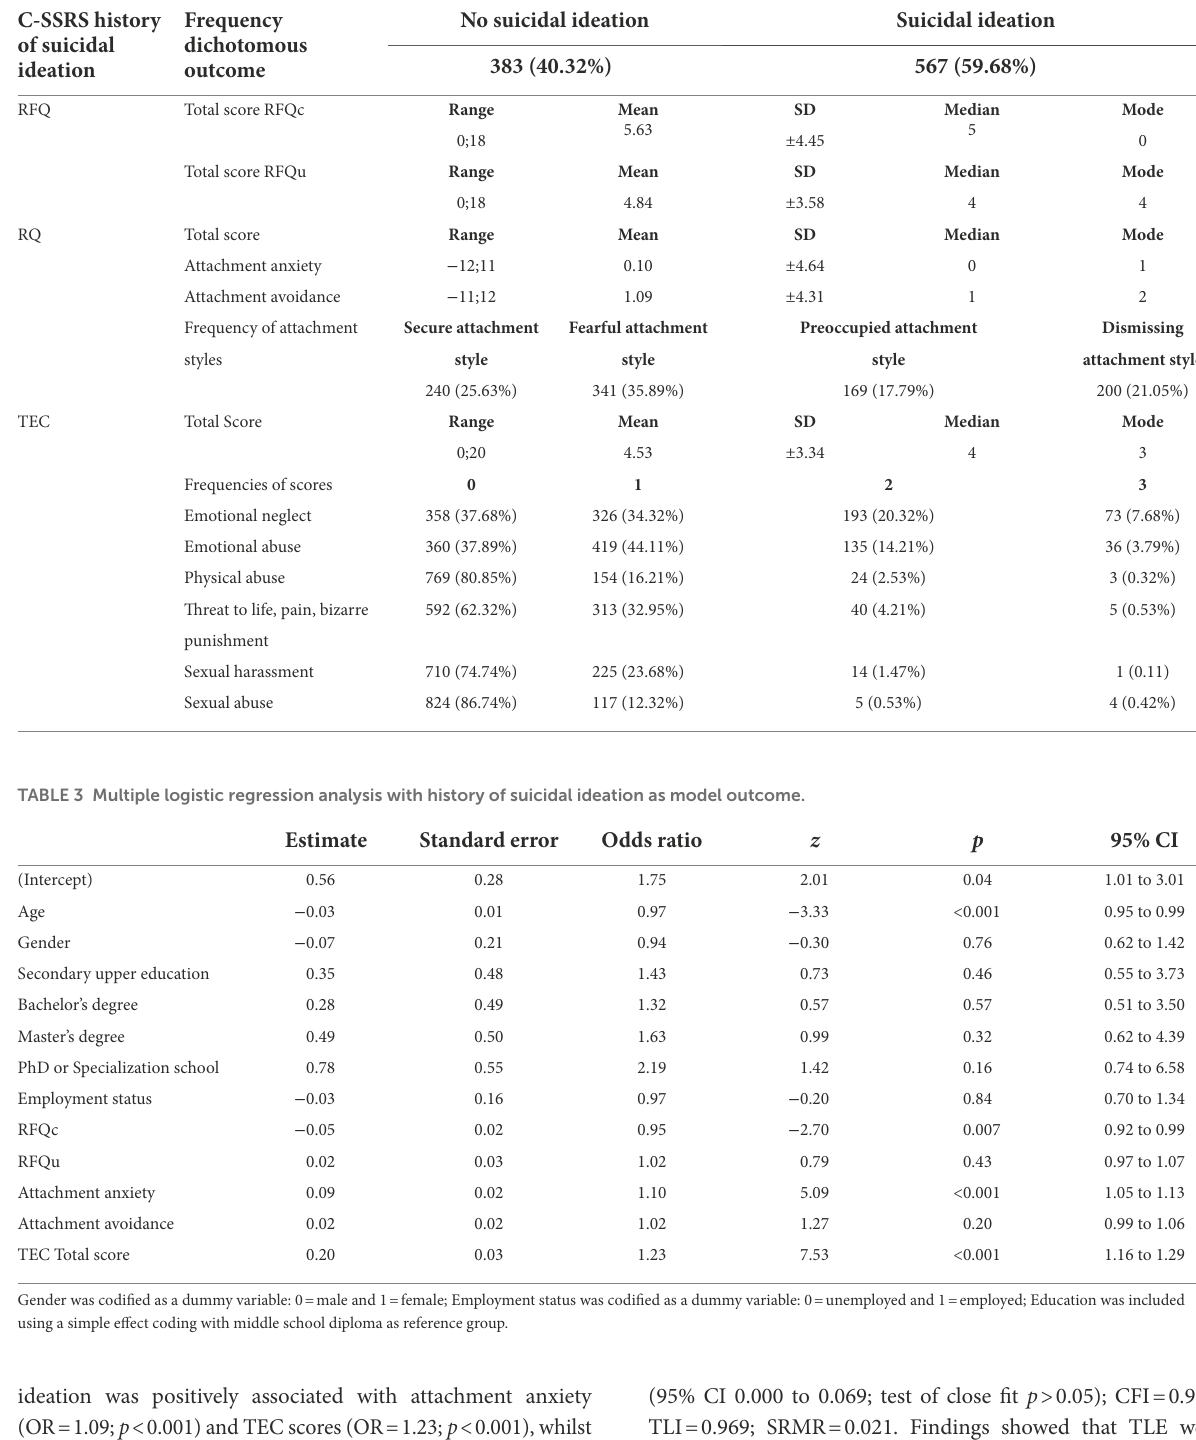
TABLE 2 Descriptive statistics of the variables under study.